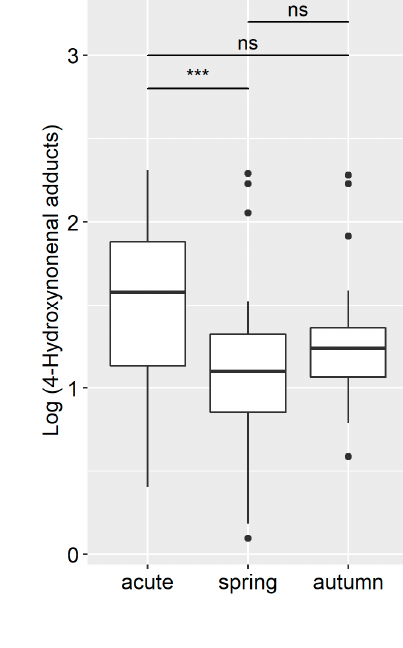
Figure 1. ( a ) Se concentrations, μ g/L, and ( b ) Sepp1 concentrations, mg/mL, in blood plasma of acutely ill COVID-19 patients (acute) and in post-COVID-19 disease patients 2 months following their discharge from the hospital: infected with COVID-19 in the spring–early summer period (spring) or in summer–autumn period (autumn). Black dots show not significant outliers. * p < 0.05;